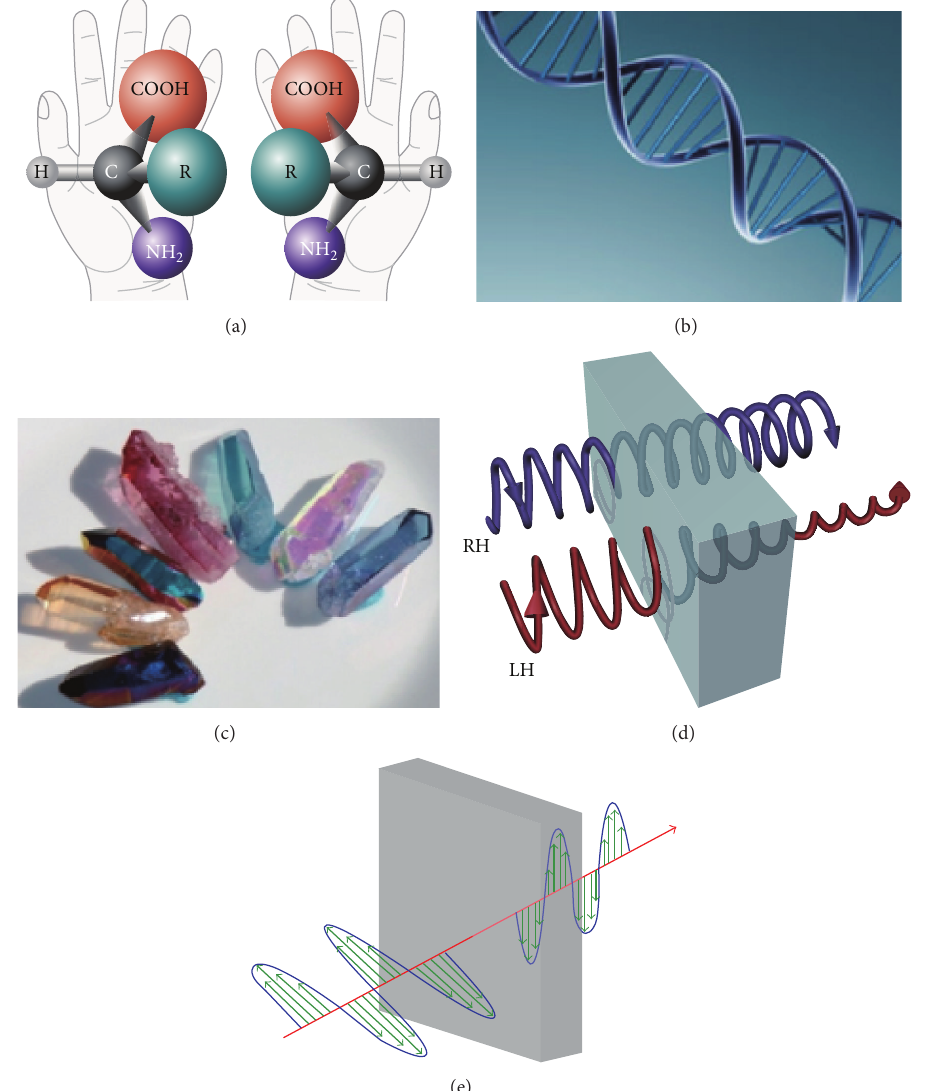
Figure 10: Classical naturally occurring chiral materials including (a) aminophenol, (b) DNA molecule, and (c) crystals. The chiral materials present (d) circular dichroism and (e) optical rotation character when illuminated by electromagnetic